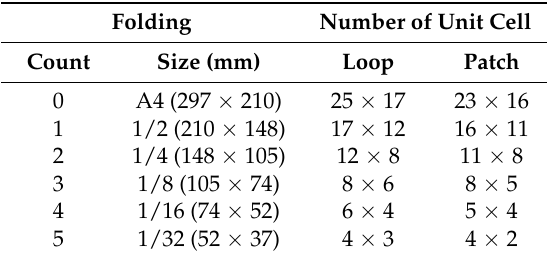
Table 1. Number of unit cell for fold